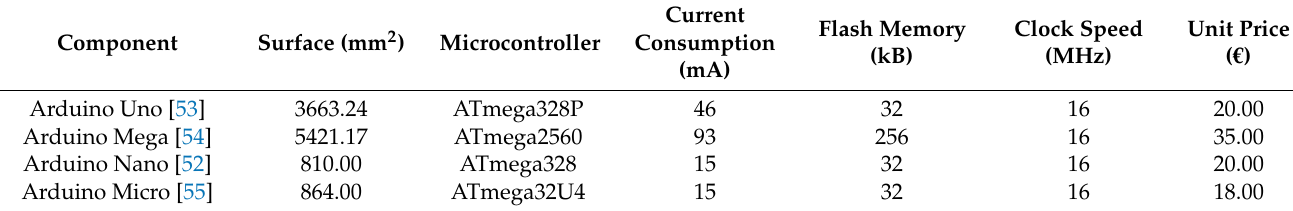
Table 1. Comparison of the Arduino